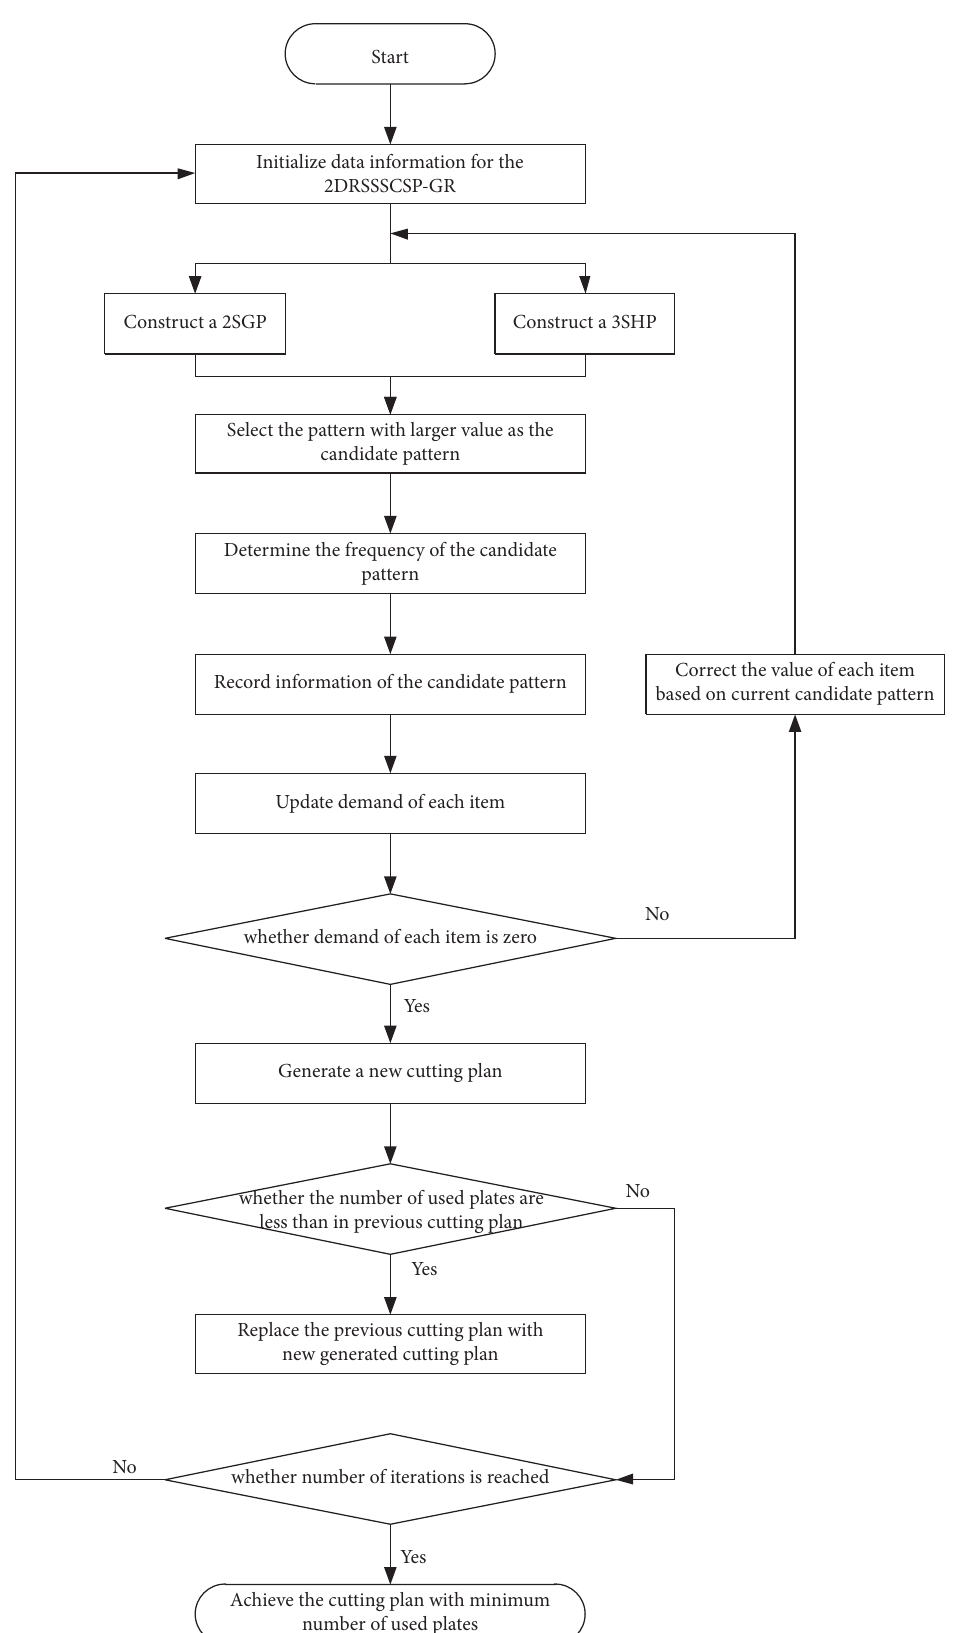
Figure 5: Flowchart of the ISHP